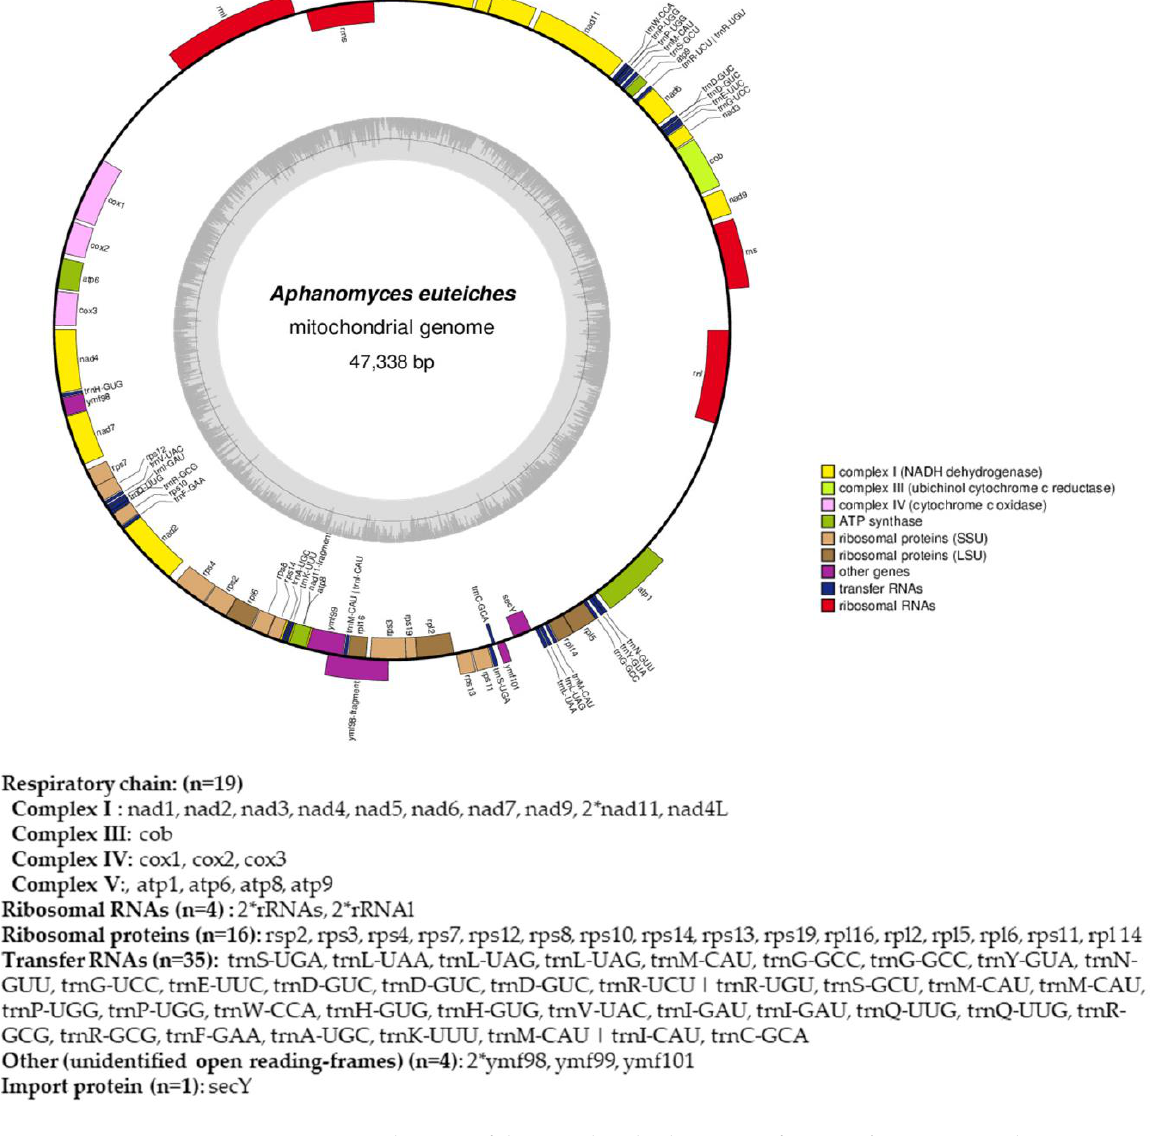
Figure 4. Circular map of the mitochondrial genome of A. euteiches . Protein coding genes, tRNA and rRNA are shown on the outer colored ring. Genes encoded on both strands are listed below. The inner ring shows the GC density.